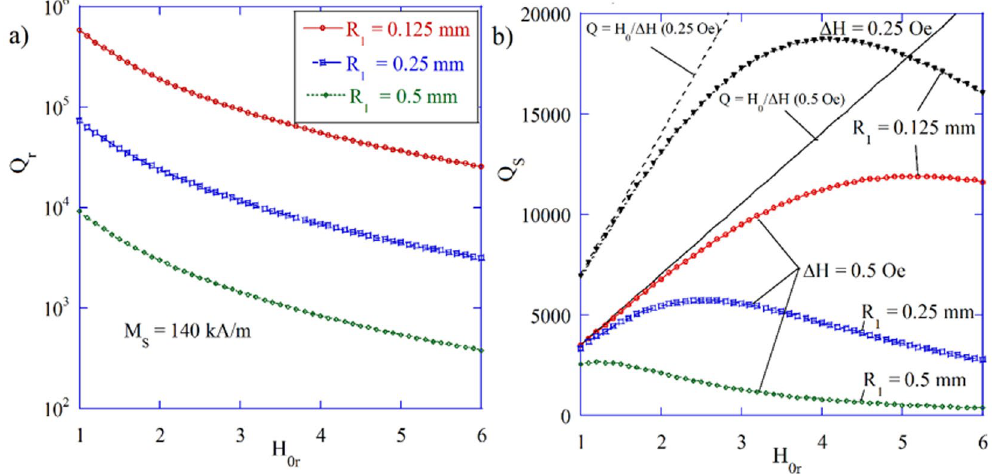
Figure 5. Q-factor at the MPR for the gyromagnetic sphere in the free space. The Q-factor of the gyromagnetic spheres of different radii situated in the free space, as computed with the TDE, ( a ) with radiation losses only ( Δ H = 0) and ( b ) with both radiation and magnetic losses ( Δ H >